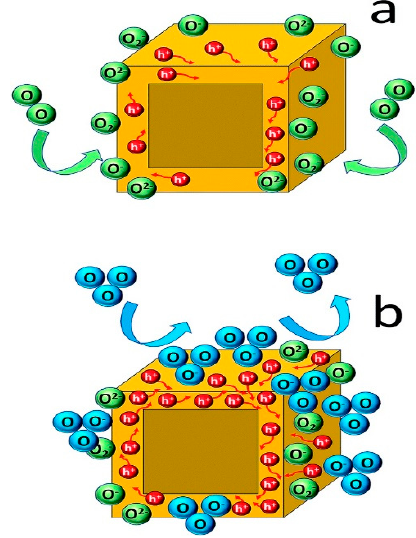
Figure 11. Schematic diagram of the gas sensing mechanism under ambient conditions ( a ) and after ozone exposure ( b ) (reproduced with the permission from reference [141]).